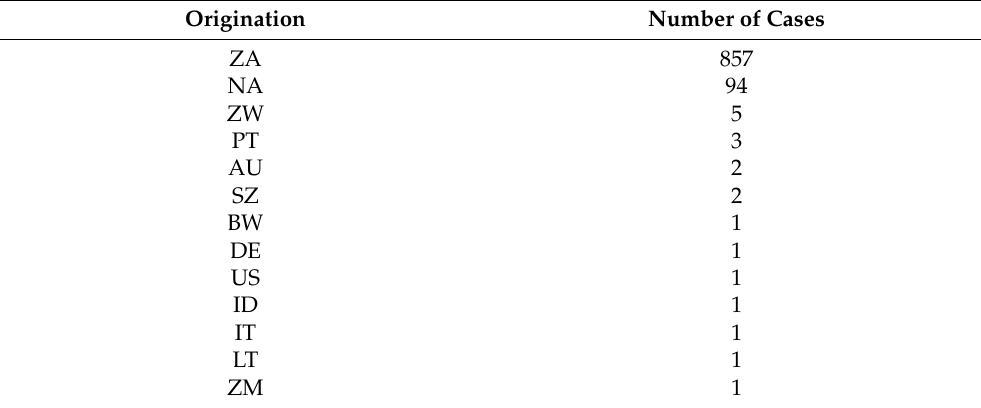
Figure 4. Routes of rhino trade cases, 2007–2017. Table 1. Trade cases of wild-sourced rhino for commercial, hunting, or personal purposes and its origins. Origination Number of